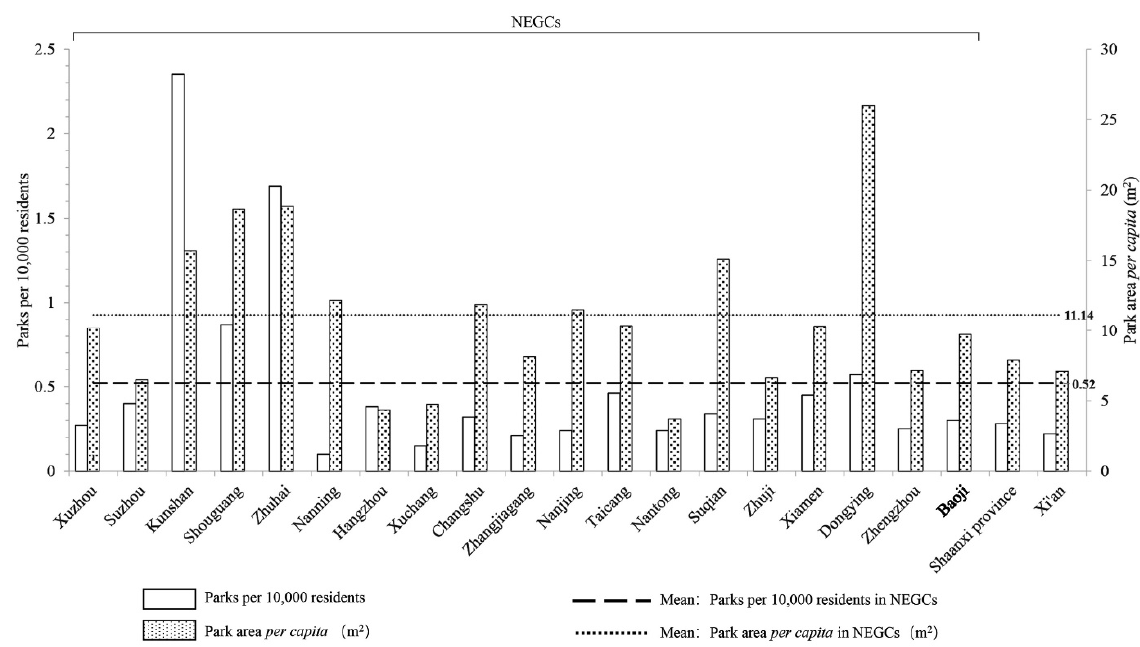
Figure 4. Comparison of urban park systems between Baoji and other NEGCs.